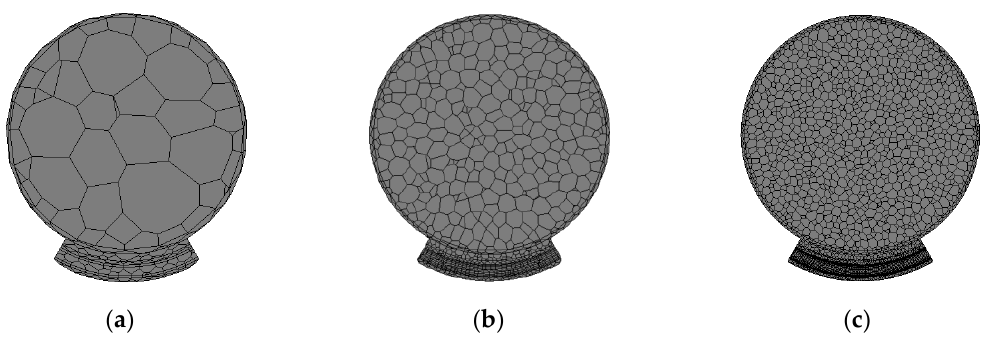
Figure 8. Sectional view of the grids at the mid-symmetry plane: ( a ) grid level 1; ( b ) grid level 4; ( c ) grid level 7.